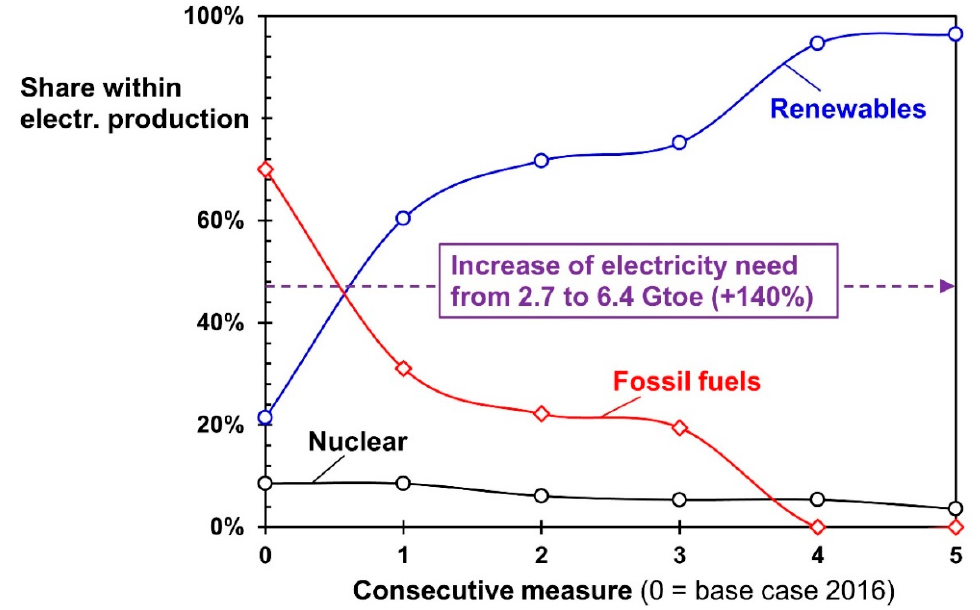
Figure 6. Share of nuclear power, renewables and fossil fuels within global electricity production for different consecutive measures (constant global population and prosperity).